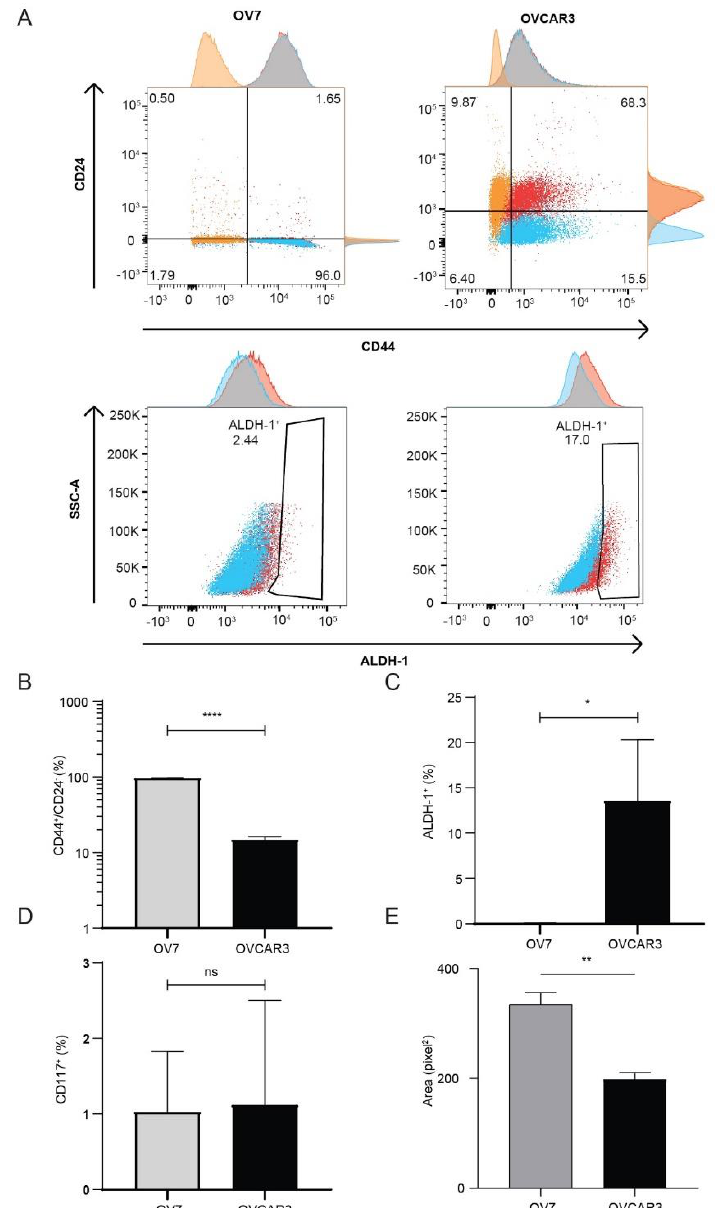
Figure 3. OV7 cells are enriched in CD24 − /CD44 + cells. ( A – C ) OV7 and OVCAR3 cells were immunostained with CD44, CD24, ALDEFLUOR or ( D ) CD117, and analyzed by FACS. ( E ) OV7 and OVCAR3 cells were embedded in soft agar to measure anchorage-independent cell growth. Bars represent the mean ± SD of three independent experiments. ****, p < 0.0001, **, p < 0.001, *, p < 0.01 Mann-Whitney test.